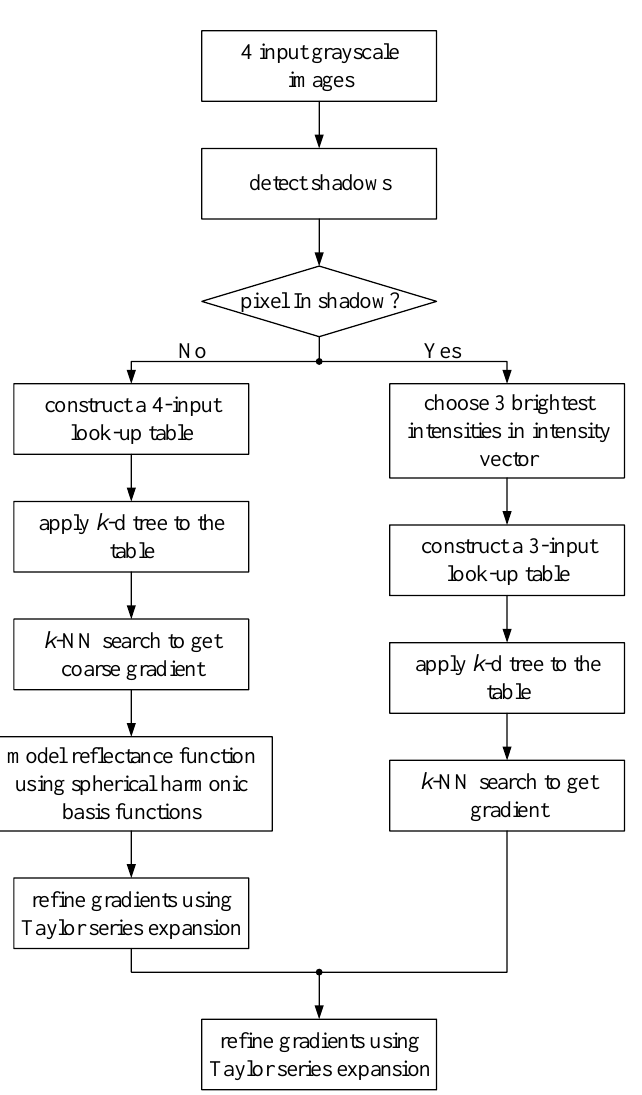
Figure 5. Flow chart of the entire 3-D reconstruction algorithm.